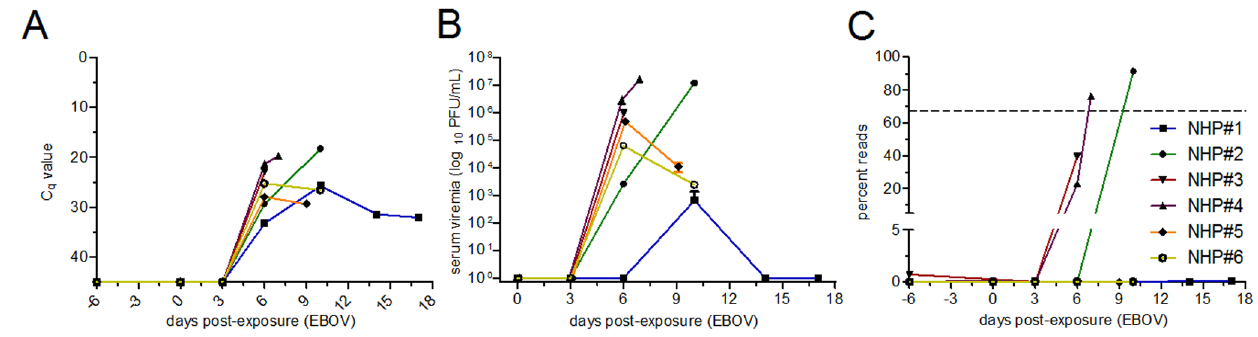
Figure 2. Detection of EBOV in challenged NHPs. Plasma samples from each NHP were assayed for the presence of EBOV by real-time PCR (A) and by plaque assay (B). Samples were run singly due to limited plasma availability. (C) Plasma samples were also assessed using the filovirus SCP panel. The dashed line indicates the signal generated by the EBOV positive control.